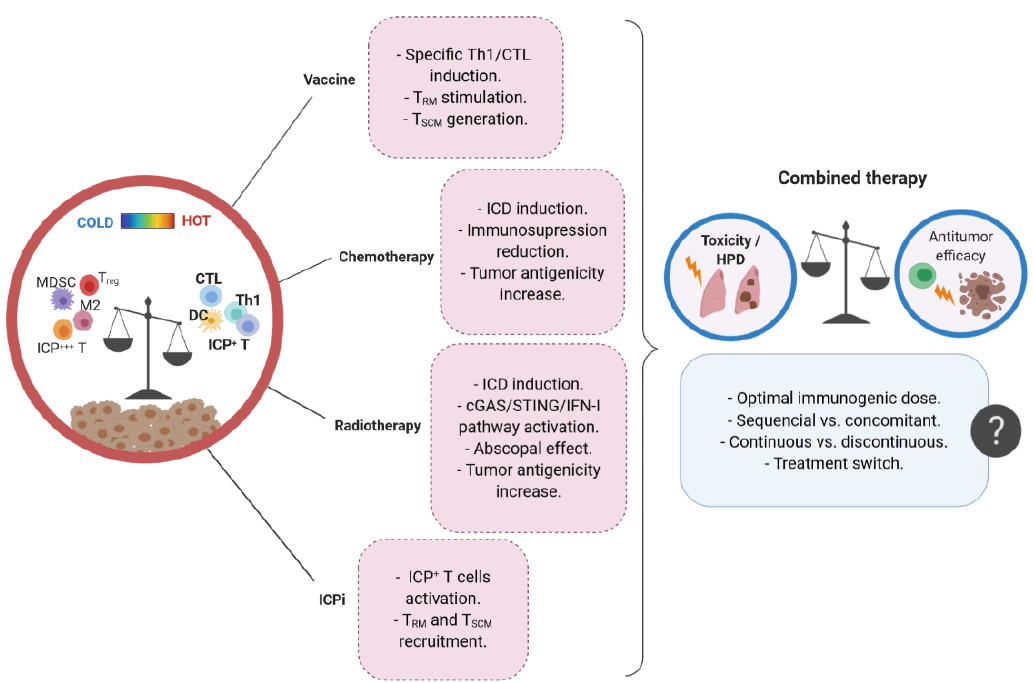
Figure 5. Parameters influencing the antitumor efficacy and toxicity of combined immunogenic therapies. Vaccines, immunogenic chemotherapy/radiotherapy, and immune checkpoint inhibitors (ICPi) act by promoting the activation of the immune system, converting ‘cold’ tumor in ‘hot’ tumors. However, treatment combination warrants special attention about the sequence, dose, and duration of each therapy to ensure durable antitumor response while avoiding deleterious immune-associated adverse events. MDSC, myeloid-derived suppressive cells; CTL, cytotoxic T cell; M2, type-2 macrophage; ICD, immunogenic tumor cell death; T RM , tissue-resident memory T cell; T SCM , stem-cell like memory T cell; HPD, hyperprogressive disease.